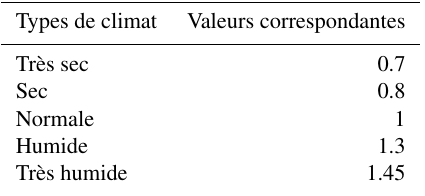
Tableau 1. Valeurs numériques relatives à chaque type de climat.